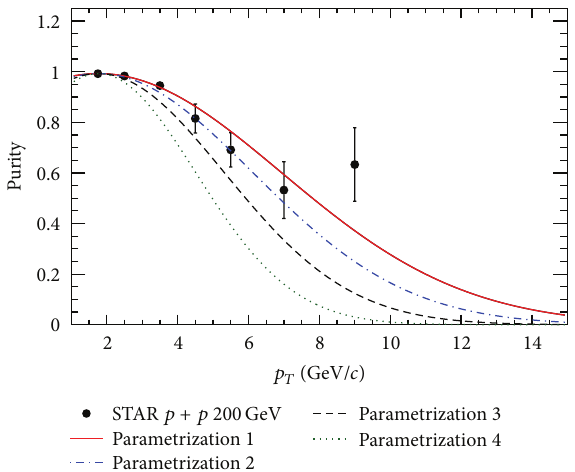
Figure 2: Electron purity measured by STAR in 𝑝 + 𝑝 collisions at √𝑠 = 200 GeV [6]. The data are fitted using a Gaussian function (“parametrization 1”). We obtained parametrizations 2 to 4 by changing the width of parametrization 1 by 1, 2, and 3 uncertainties of the width of parametrization